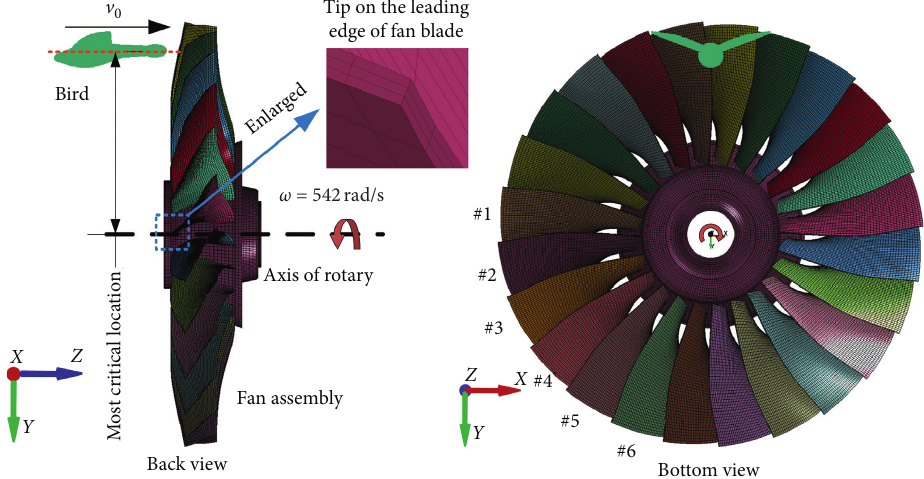
Figure 7: FE model of a fan assembly subjected to a